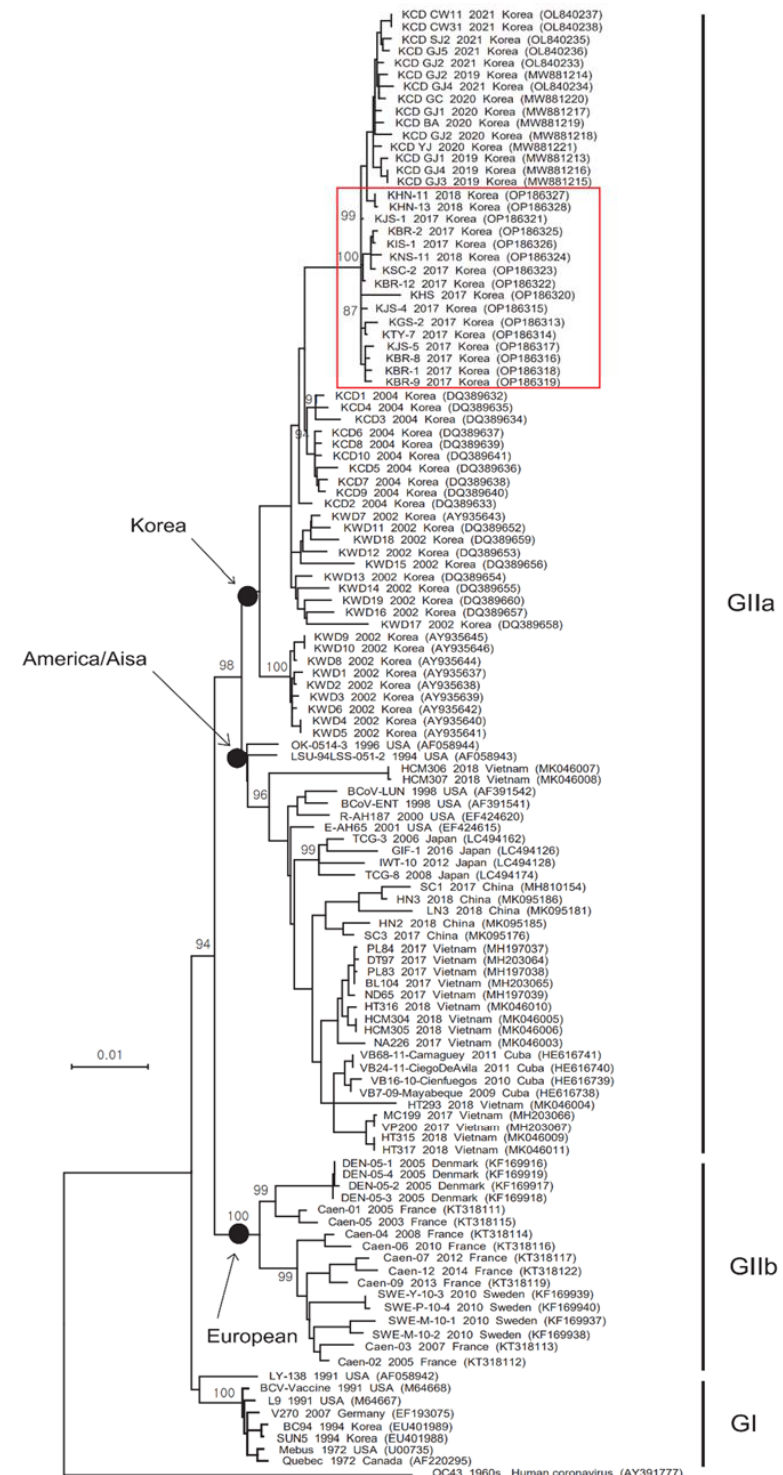
Figure 1. Phylogenetic tree based on the complete S gene sequences of BCoV reference strains isolated worldwide, including the 2017–2018 strains detected in this study. A maximum-likelihood phylogenetic (LogL = − 15690.97) tree was constructed using the Tamura-Nei model and the Nearest- Neighbor-Interchange method. Bootstrap values (1000 replicates) ≥ 70% are shown at the nodes, and the sequences identified in this study are marked by a red box.